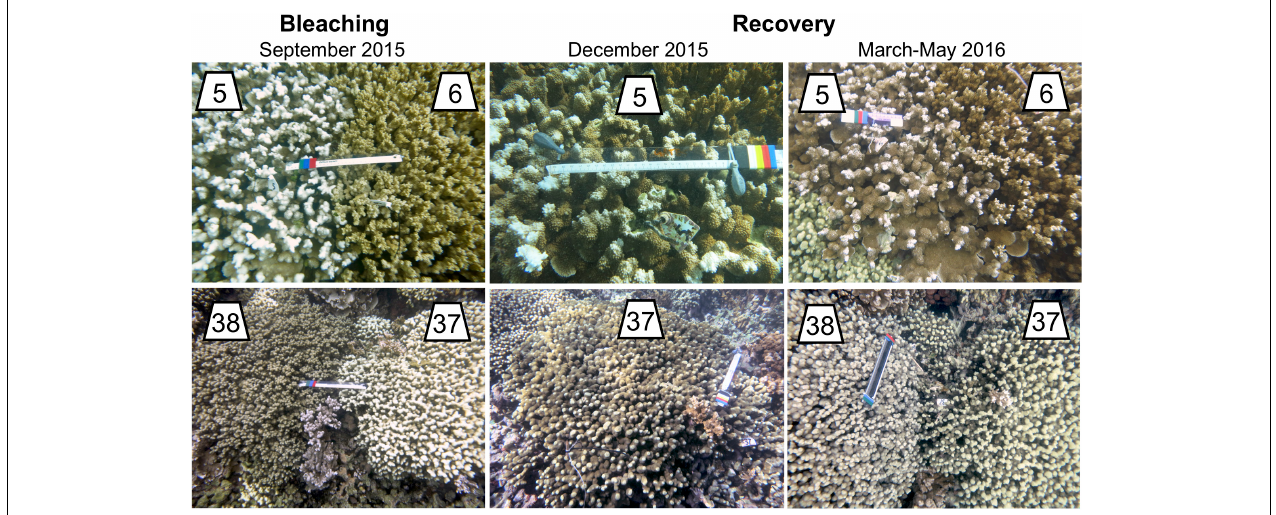
FIGURE 2 | Representative images of tagged bleached and non-bleached corals. Top row: M. capitata pairs 5 and 6; Bottom row: P. compressa pairs 37 and 38. Left column shows pairs during the bleaching event (Sept. 2015). Center column shows the bleaching susceptible colony of the pair after 1.5 months of recovery (Dec. 2015). Right column shows the same pairs after 3–6 months of recovery [Mar. 2016 (colonies 5 and 6); May 2016 (colonies 37 and 38)].